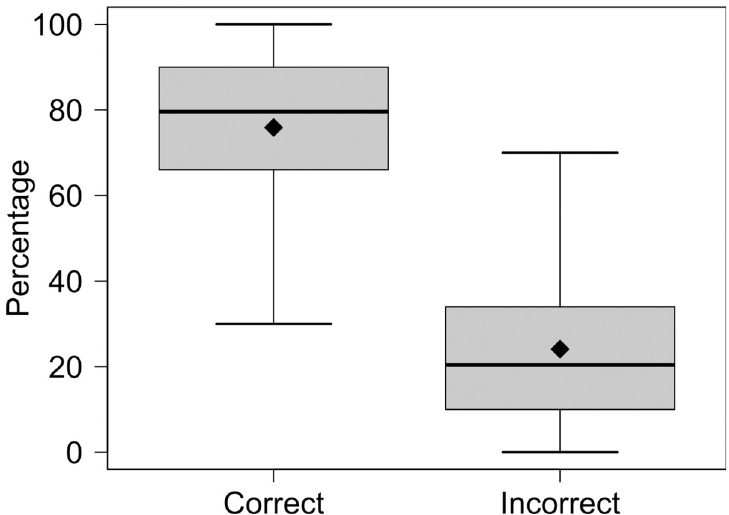
Fig 2. Percentage of household selection success in clusters, via satellite imagery in Cameroon. Results of correctly and incorrectly selected household using high-resolution satellite background images in QGIS . The thick lines indicate the median, the diamonds display the mean, the box delimits the interquartile range (IQR) and the whiskers give the minimum and maximum values inside the 1.5 IQR.